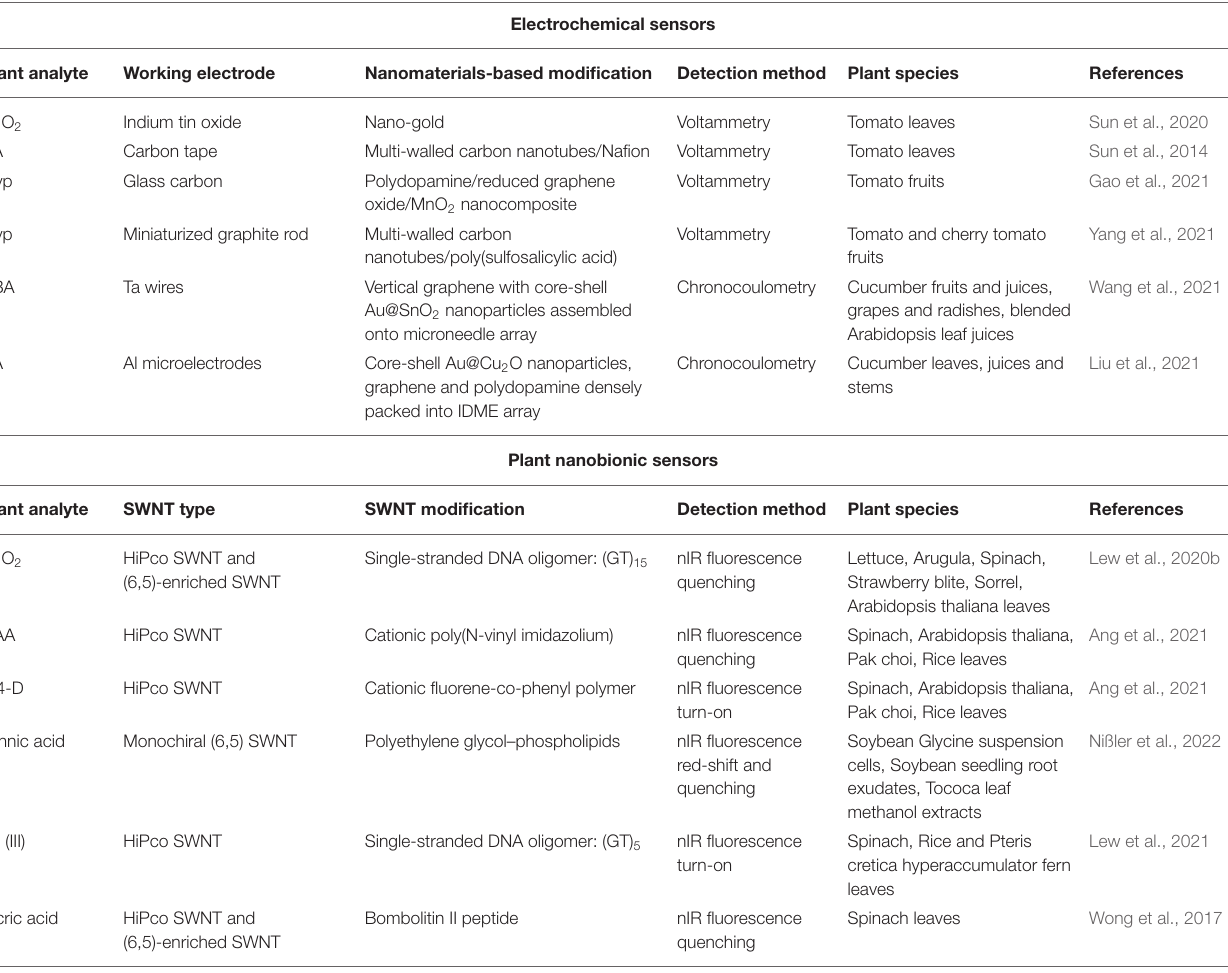
TABLE 1 | Comparison of the various in vivo electrochemical and plant nanobionic